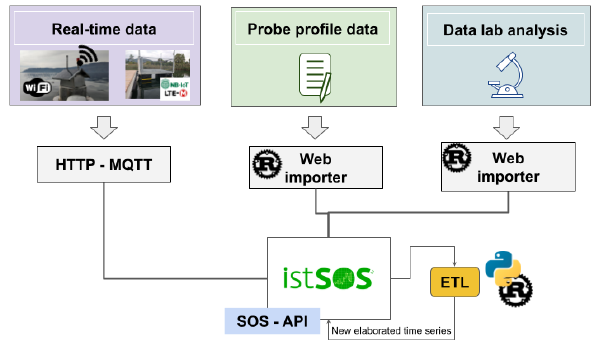
Figure 4. Data importing into istSOS.